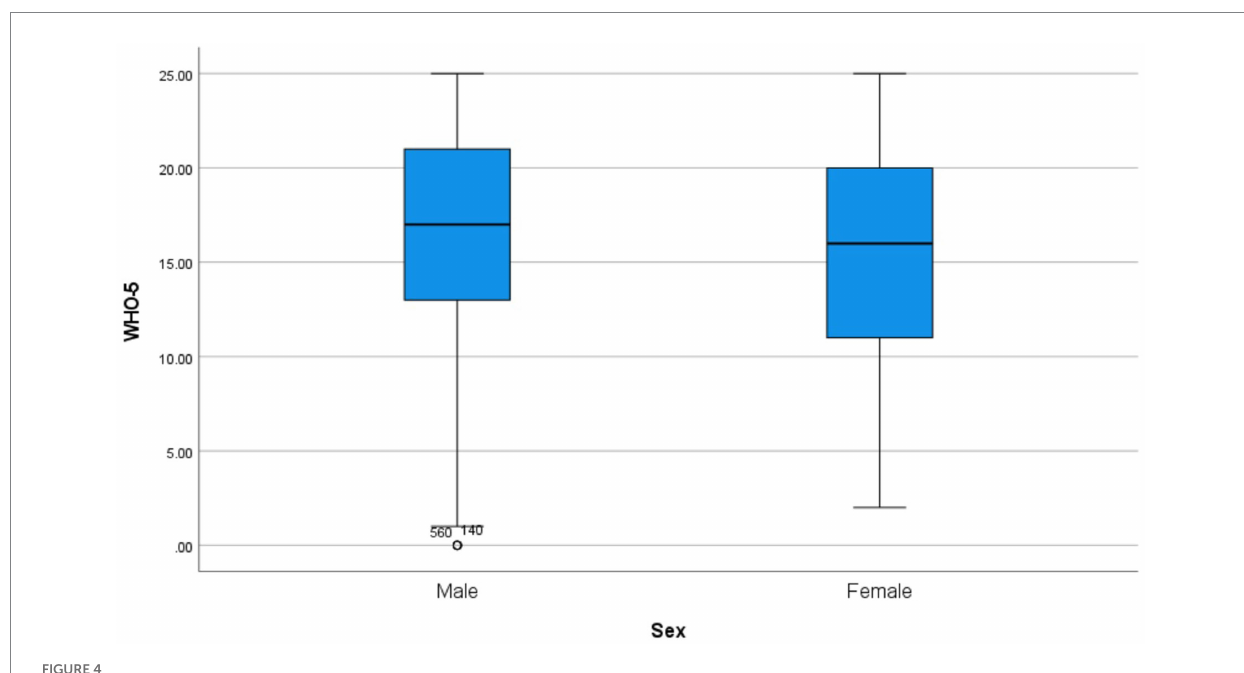
FIGURE 4 Well-being index scores by